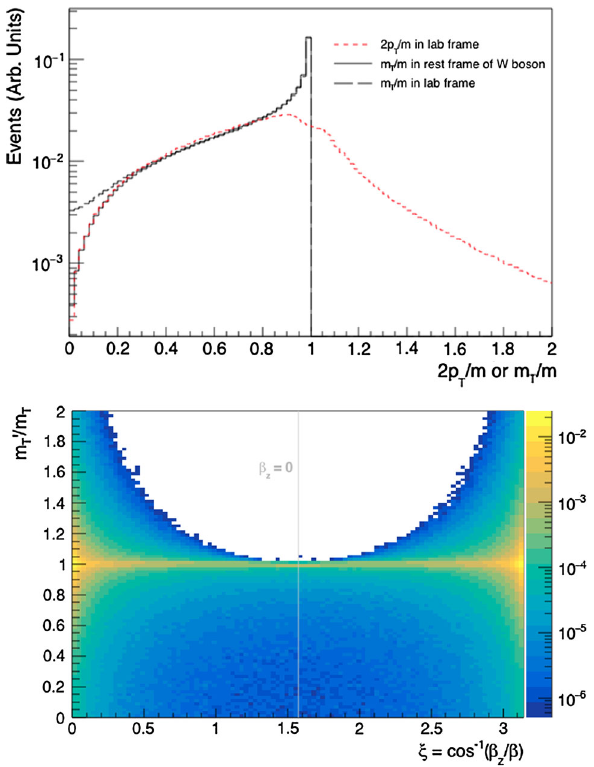
Fig. 1 Top: Distributions of transverse mass values in the parent rest frame and in the laboratory frame for a W boson decaying to a charged lepton and neutrino and recoiling against a hadronic system with trans- verse momentum of at least 5 GeV. Also shown (red/light dashed) is the equivalent distribution of charged lepton transverse momenta mea- sured in the laboratory frame. Events were simulated with PYTHIA v.8.240 [16], specifying the qg → Wq process with ISR, FSR and hadronisation disabled. The transverse mass has been normalised to the per-event mass of the W boson m for each event to illustrate the form of the Jacobian peak. Bottom: The distribution of the ratio of the transverse mass values measured in the laboratory and W boson frames plotted as a function of the angle ξ between the boost and the beam-line ( ˆ z direction) defined by cos ξ ≡ (β z